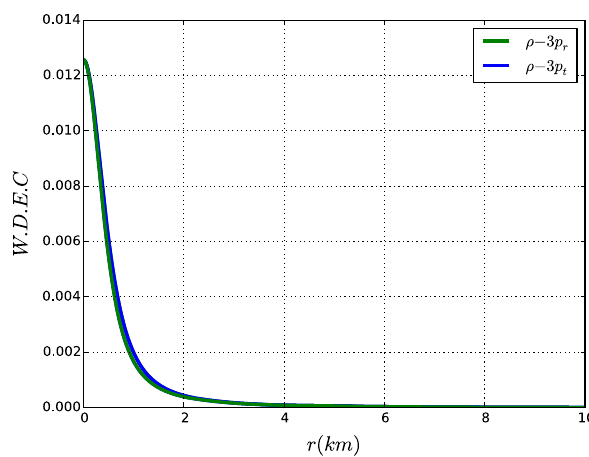
Fig. 7 Energy density ρ against radial distance r